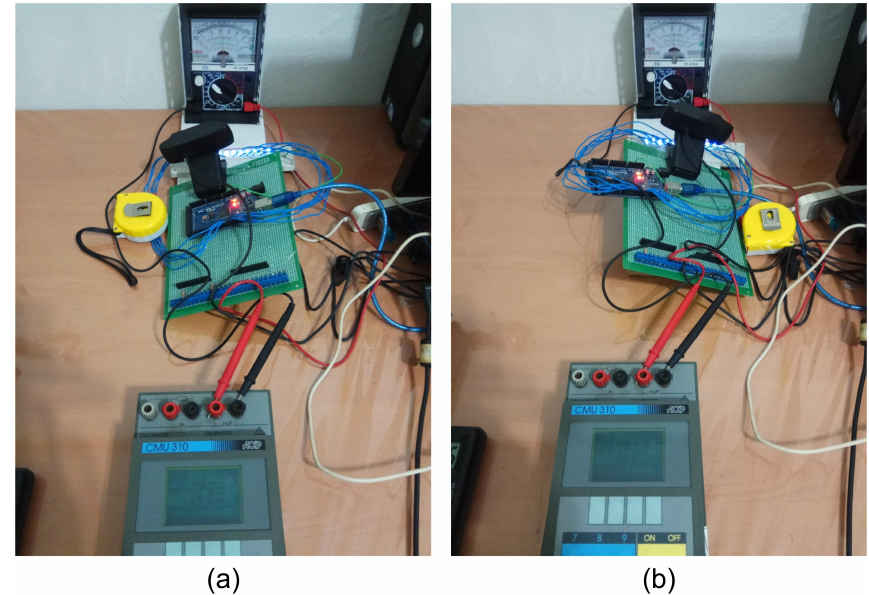
Figure 16. ( a ) Rotating the camera left will make the A-meter in the captured image rotate to the right. ( b ) Rotating the camera right will make the A-meter in the captured image rotate to the left.